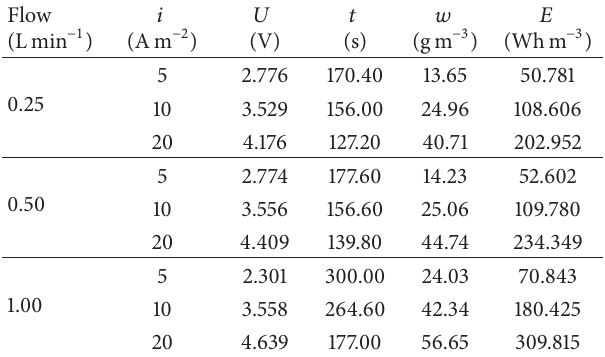
Table 2: Consumption of electrode ( 𝑤 ) and energy ( 𝐸 ), mean potential drop ( 𝑈 ), and treatment time ( 𝑡 ) to obtain an As con- centration of 10 𝜇 g L −1 during the EC treatments with natural water performed at liquid flow rates of 0.25, 0.50, and 1.00L min −1 and applied current densities of 5, 10, and 20 Am −2